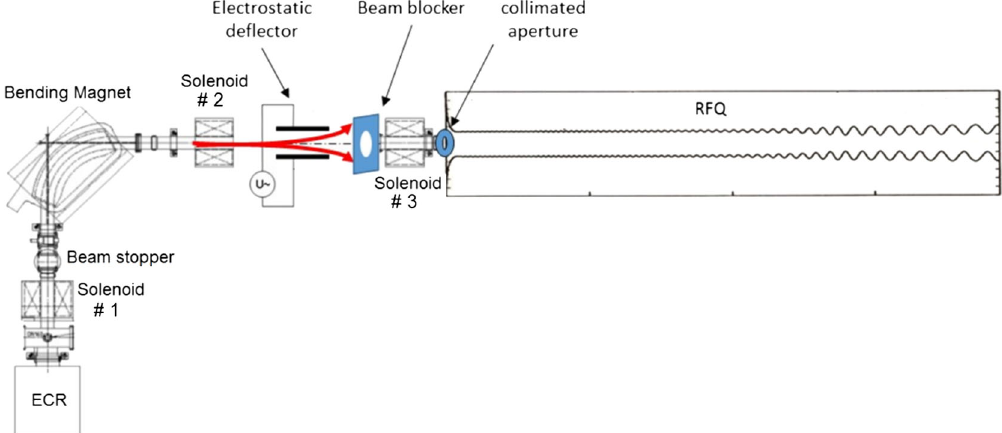
FIG. 1. Schematic top view of the SARAF injector, including the ECR ion source, LEBT, and RFQ, including deflection electrodes for beam-left and beam-right deflection and beam blocker.